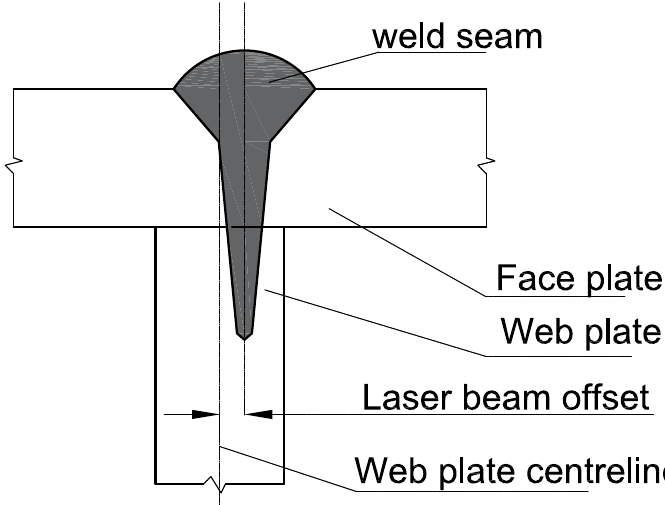
Figure 1. Stake welded tee joints